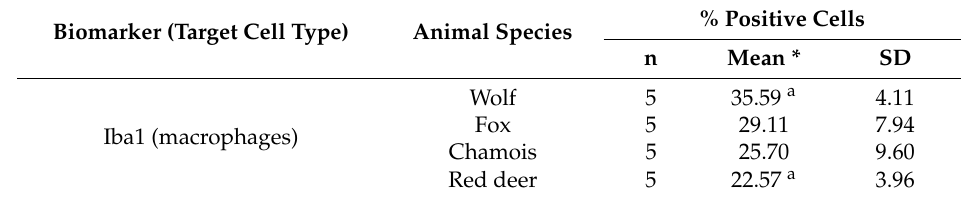
Table 3. Percentages of cells staining positive for inflammatory cell biomarkers in skin lesions from four